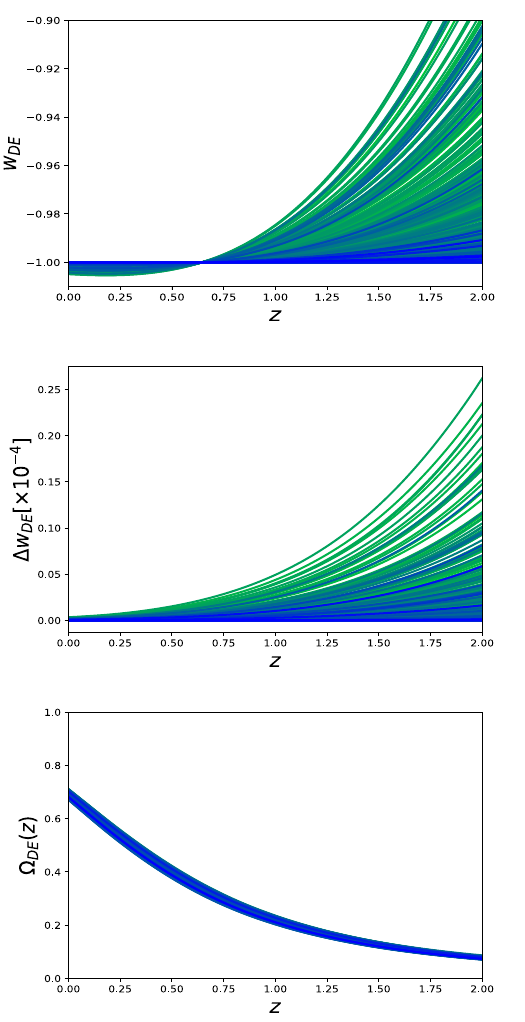
Fig. 4 The constraints on g ( z ) as a result of the data. These show the posterior probability Pr ( g | z ) : the probability of g as normalized in each slice of constant z , with color scale in confidence interval values. The 1 σ and 2 σ confidence intervals are plotted as black lines and red lines correspond to the best-fit values found over the analysis, while dotted